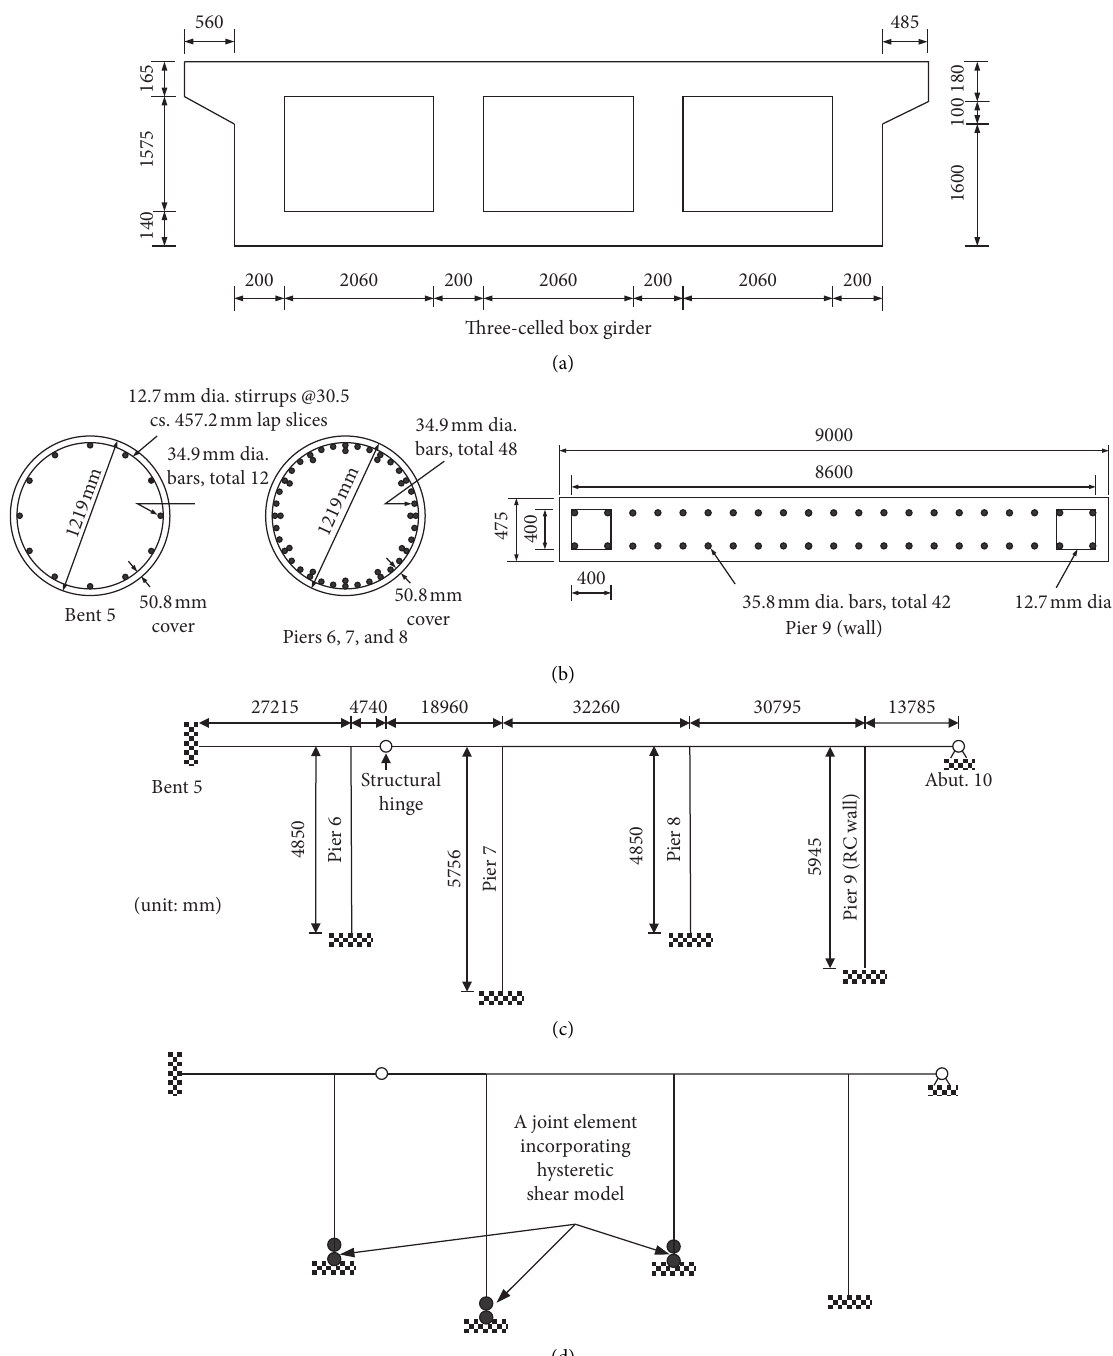
Figure 3: Analytical model of collector distributor 36. (a) Three-celled box girder cross section. (b) Cross sections of the columns and pier wall. (c) Structural model (flexure-axial interaction). (d) Structural model with shear (flexure-shear-axial